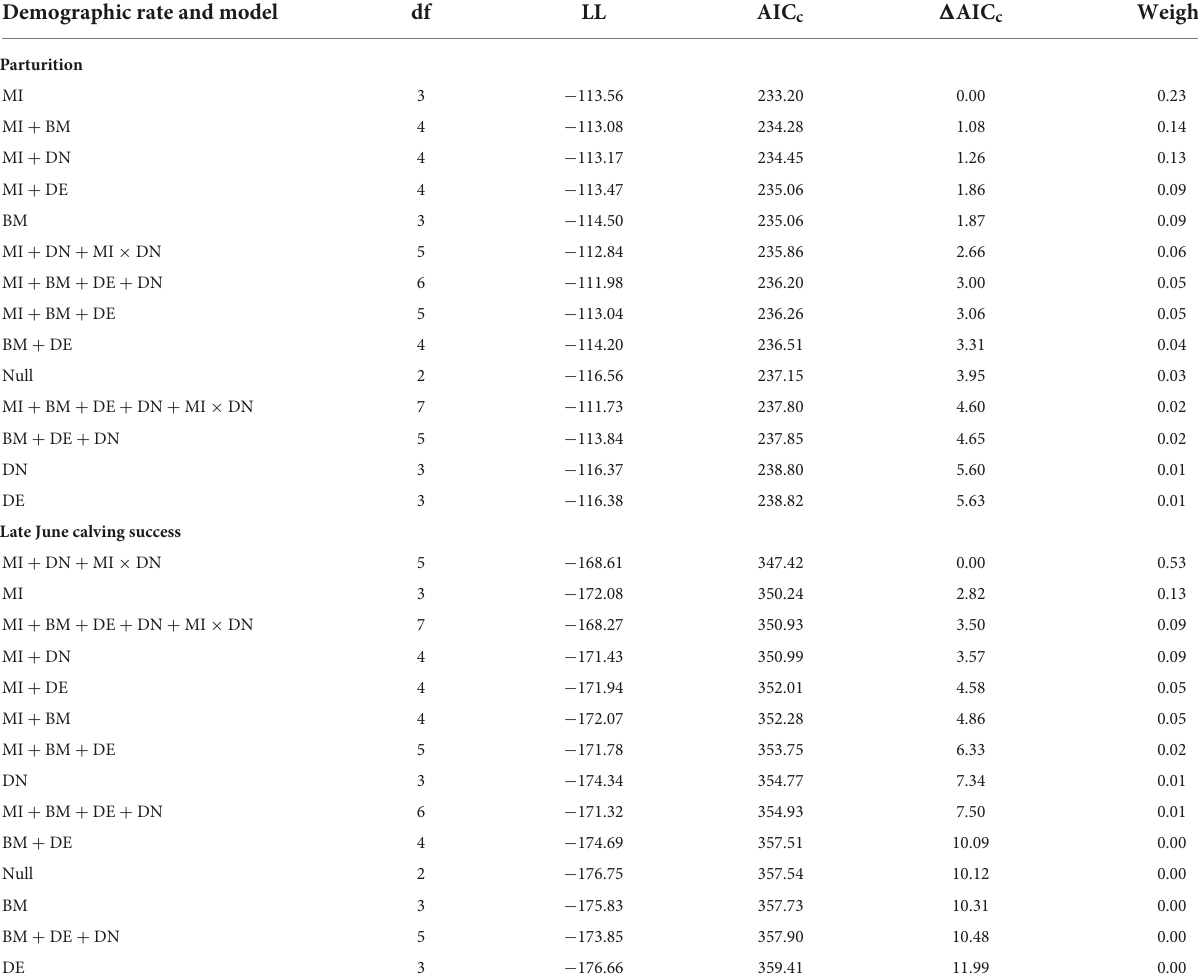
TABLE 1 Model selection criteria for individual-level models of female caribou parturition and late June calving success in the Central Arctic Herd, Alaska, 2003–2020. Demographic rate and model df LL AIC c (cid:49) AIC c